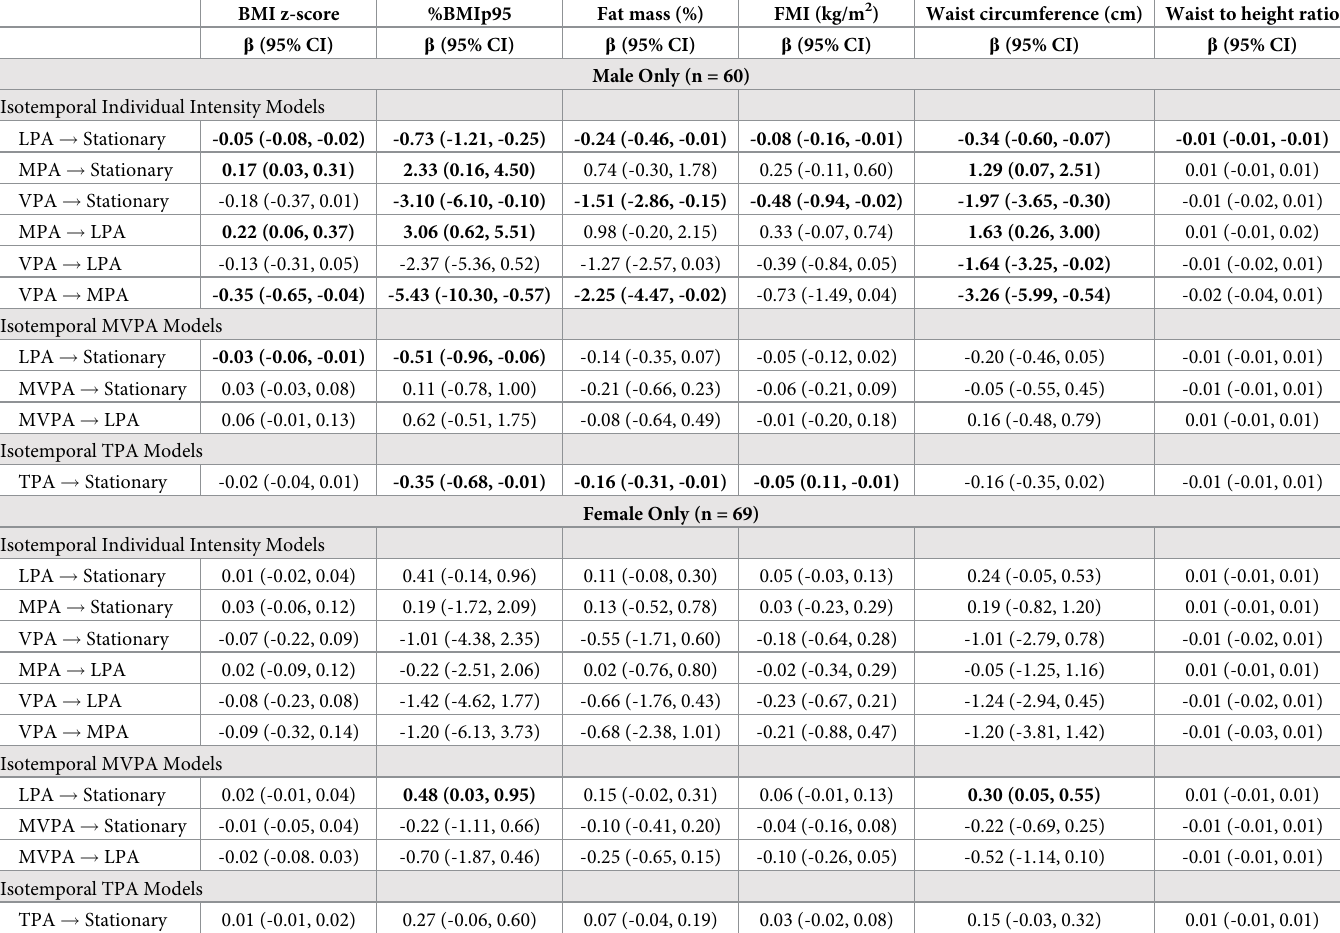
Table 5. Isotemporal substitution of movement behaviors with adiposity health indicators by sex in preschool children with overweight and obesity participating in the baseline assessment of the TX CORD secondary prevention study (N =